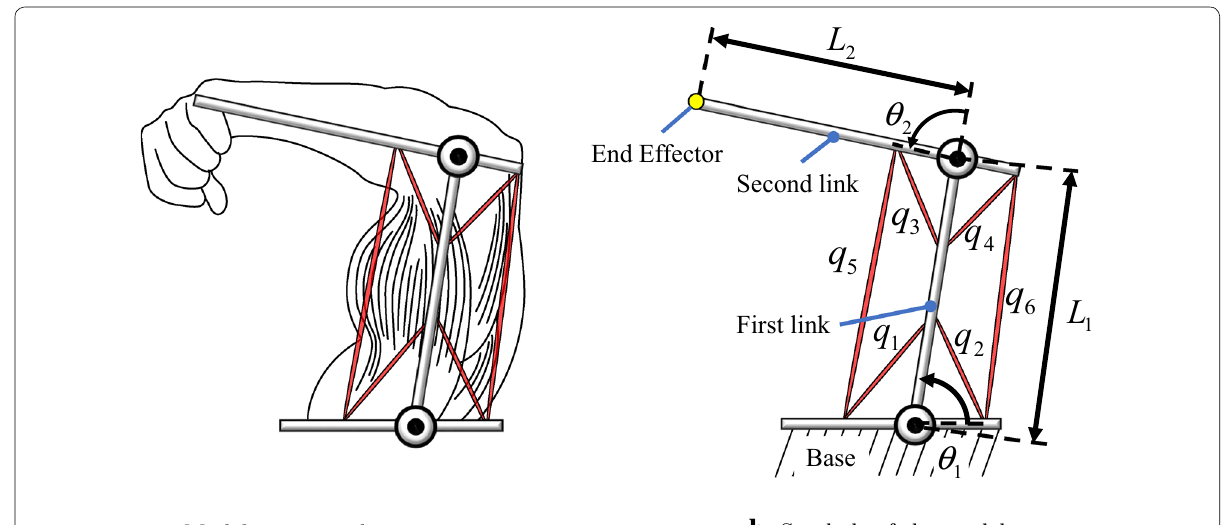
Fig. 1 Musculoskeletal structural model (two-link with